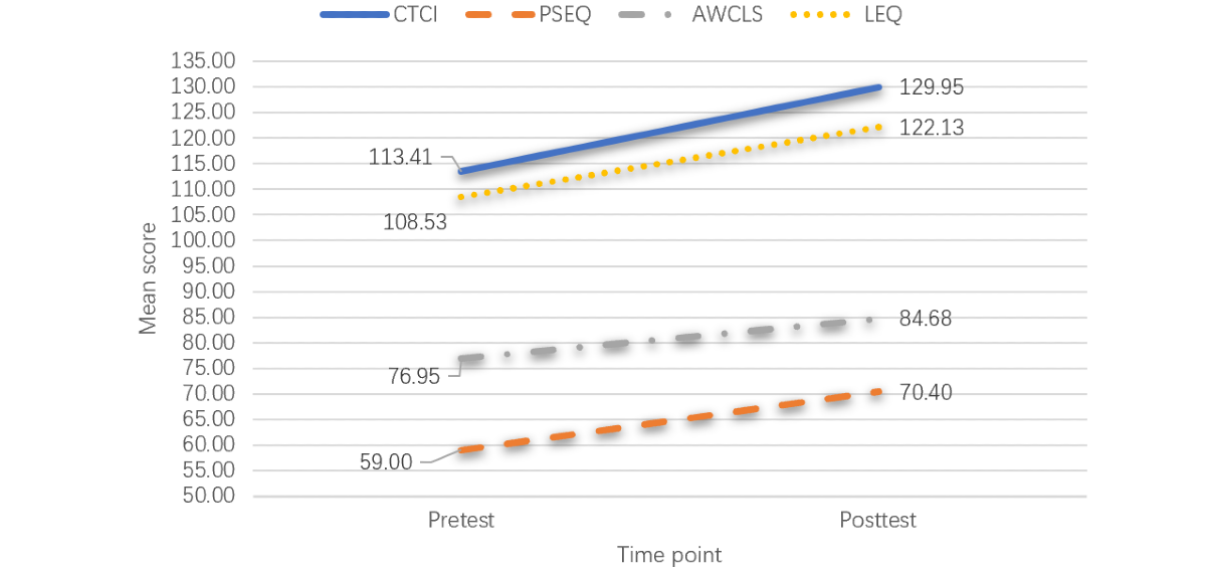
Figure 2. Mean score pretest and posttest (N=150) for AWCLS. AWCLS: attitudes toward a web-based continuing learning survey; CTCI: clinical